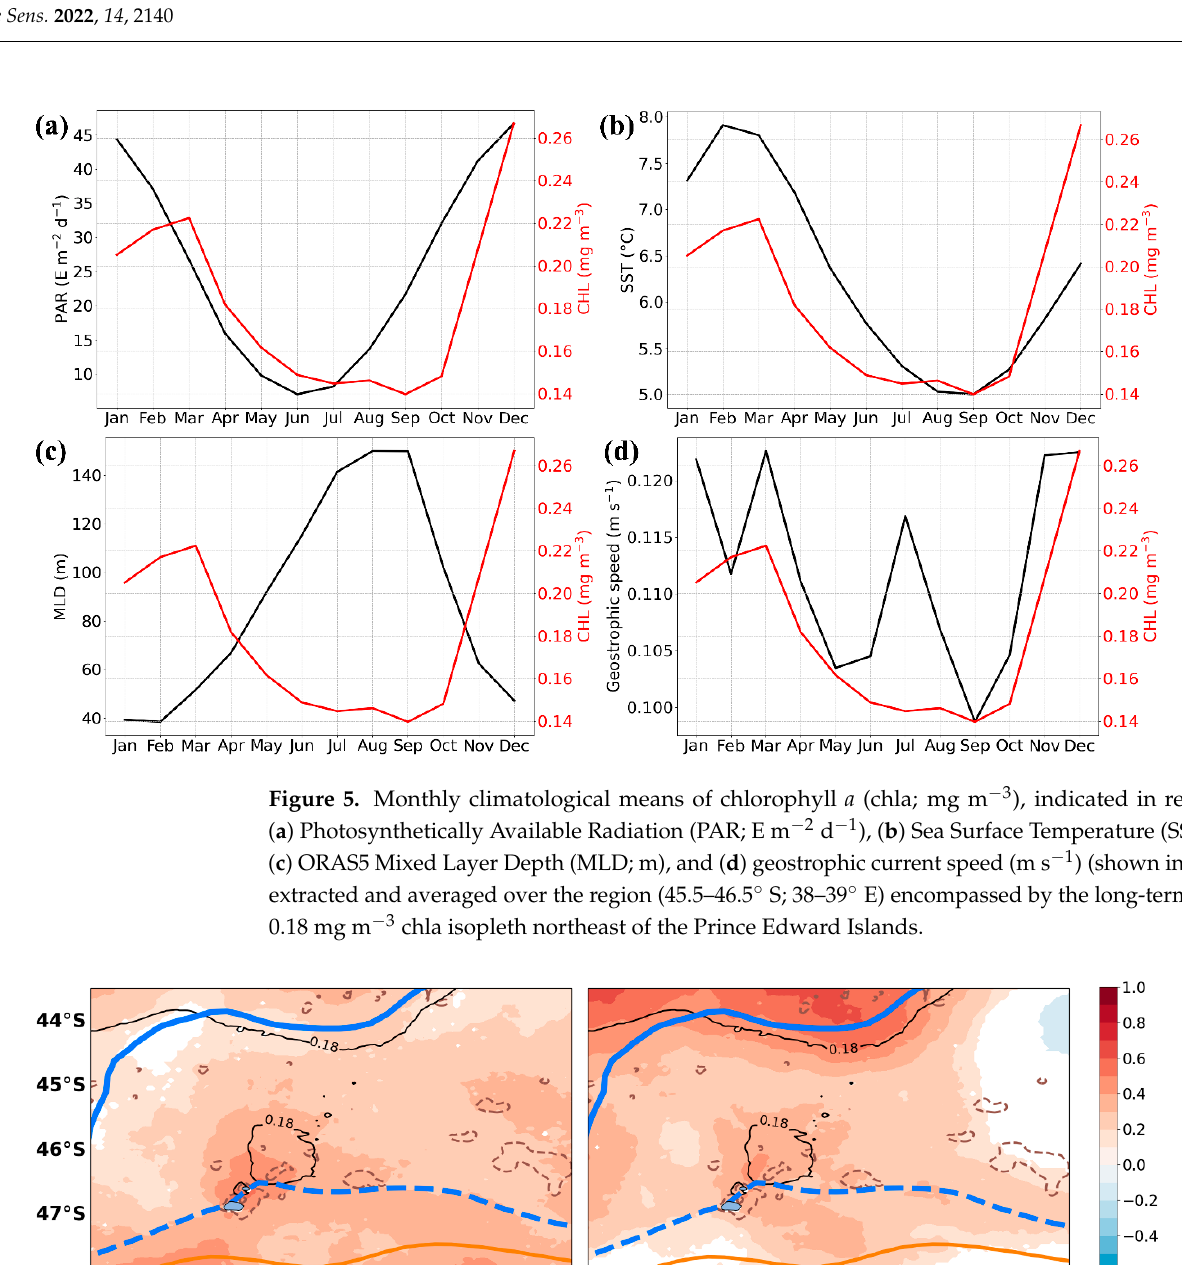
8 of 25 Figure 4. ( a – l ) Monthly (January to December) climatology (1997–2020) of SeaWiFS and MODIS Aqua Photosynthetically Available Radiation (PAR; E m − 2 d − 1 ). The black contours indicate the low- est and highest chla (mg m − 3 ) concentrations that formed unique closed contours in our region of